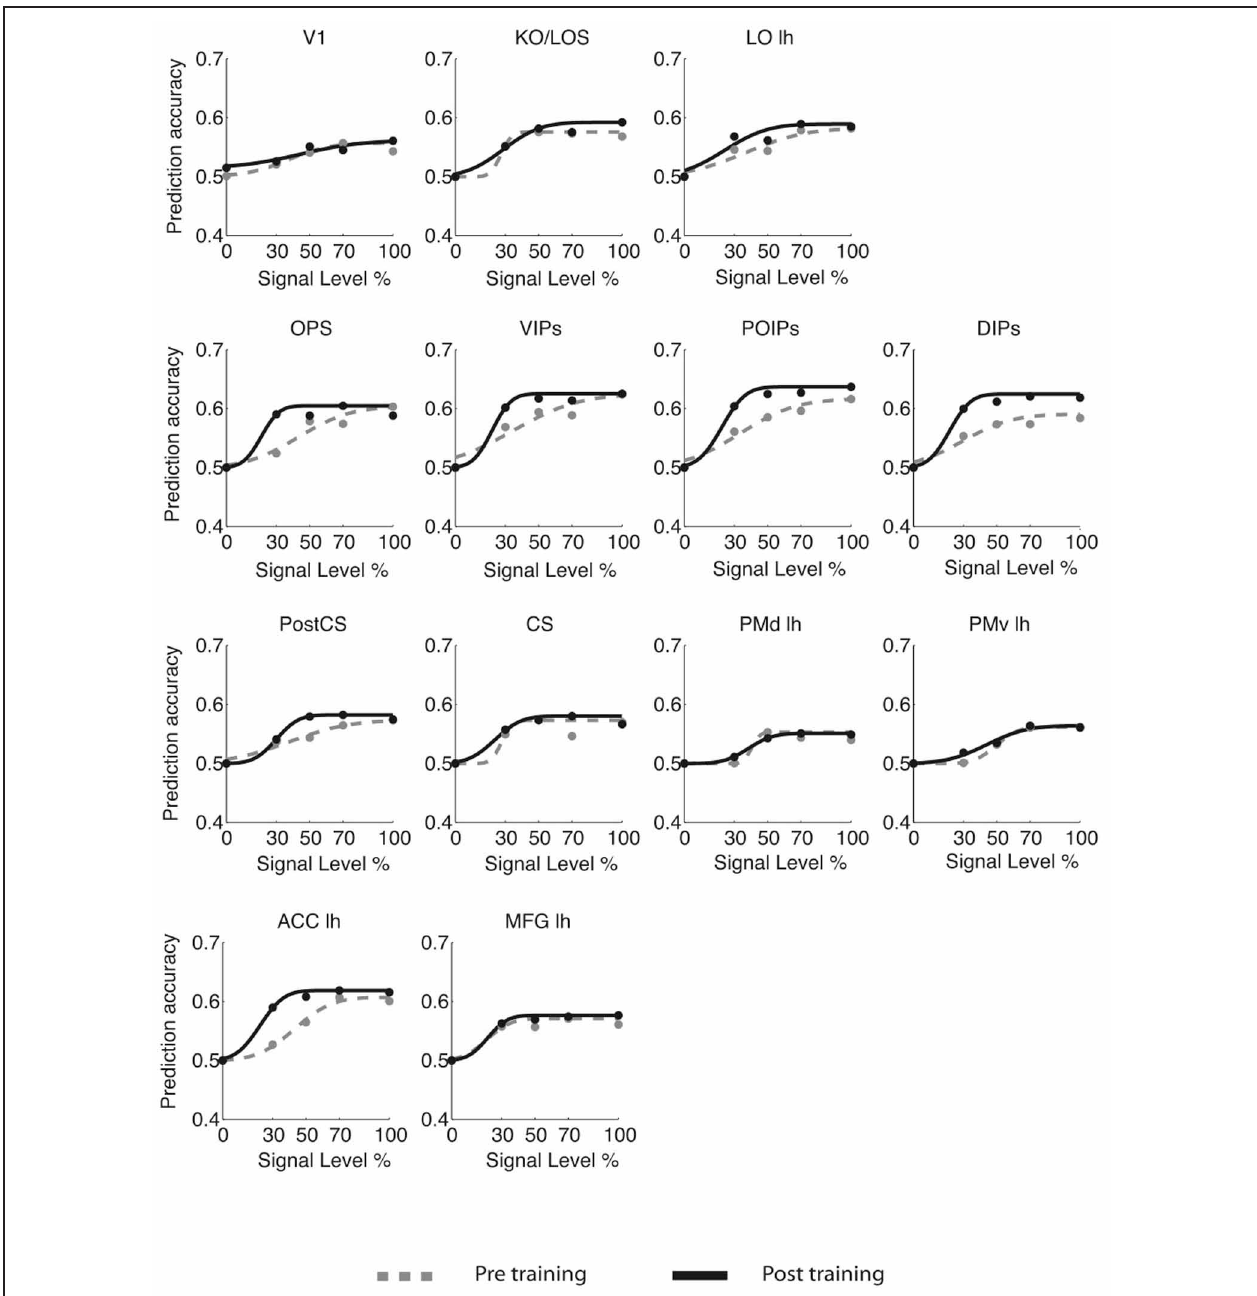
FIGURE 4 | fMR-metric functions for older adults. fMR-metric functions are shown for each ROI, for both pre- (gray dotted lines) and post-training (black solid lines) sessions. Plotted data points